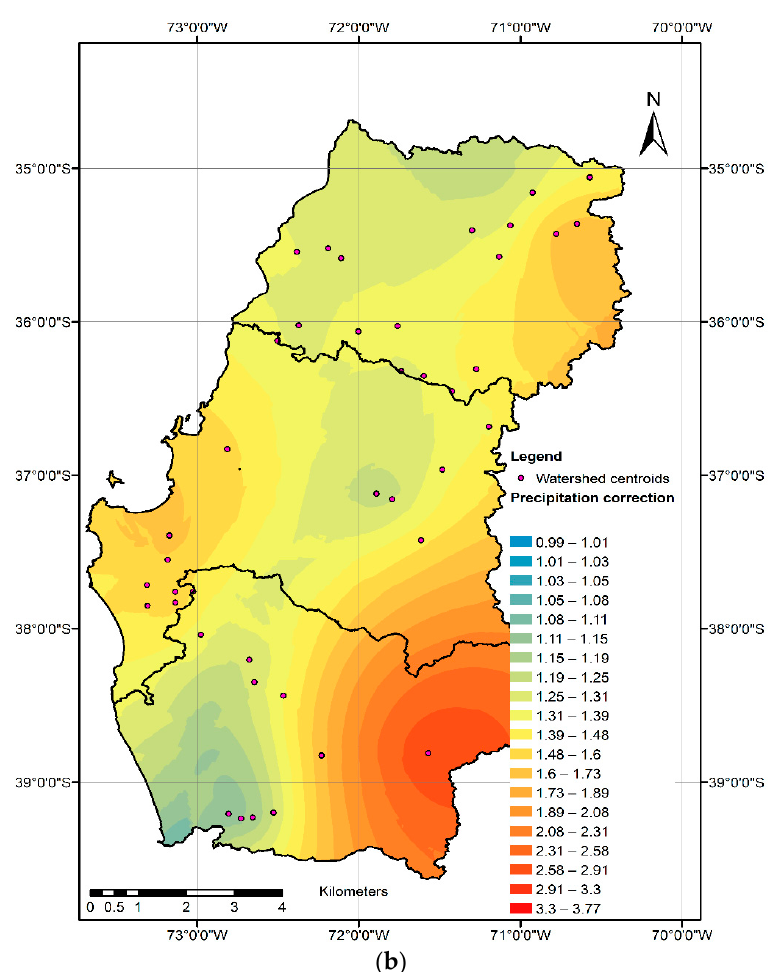
Figure 4. ( a ) Estimated average annual precipitation based on the results of inverse modeling and a cokriging-z interpolation; ( b ) Spatially distributed factor for precipitation correction using an approximation of the inverse model and a cokriging-z interpolation. Made by the authors.